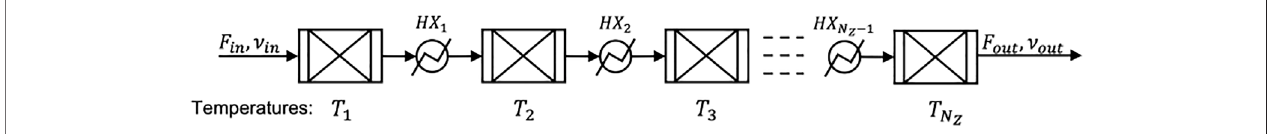
FIGURE3| PBRdividedinto N Z isothermal,equal-volumestageswithheatexchangersforinter-stagecooling/heating.Thedashedlinesrepresentthepresenceof additional reactor and heat exchangers depending on the number of stages considered in the arrangement.